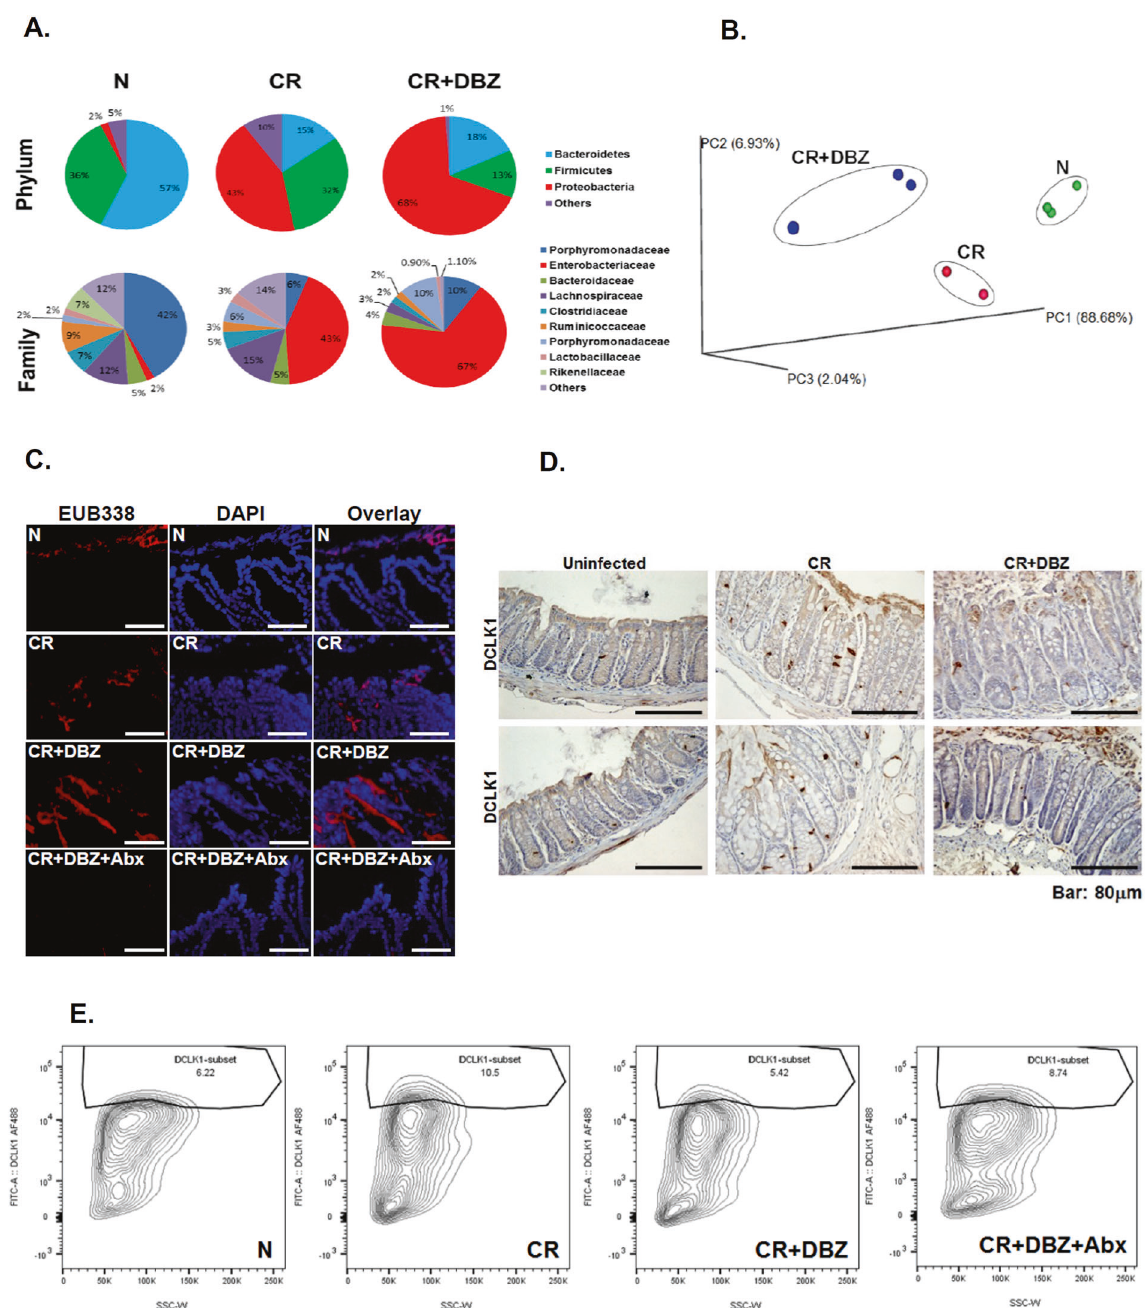
Fig. 6 Microbial dysbiosis coincides with downregulation of crypt DCLK1 following Notch blockade. A Fecal samples from uninfected (N), CR-infected (CR), and CR + DBZ-treated mice were subjected to 16S rDNA sequencing and relative abundance of phyla and families were compared. Each chart represents the taxonomic composition in the indicated groups ( n = 10 mice/group). B Principal coordinate analysis (PCoA) based on weighted UniFrac distances between bacterial communities. Please note signi fi cant separation of microbial communities in fecal samples from CR + DBZ mice when compared to either uninfected (N) or CR-infected (CR) mice ( P < 0.05). C The bacteria in the colonic tissues of N, CR, CR + DBZ, and CR + DBZ + Abx-treated mice were detected by FISH using a general bacterial 16S probe (red, TexasRed- Eub338; bar = 100 μ m; n = 3 independent experiments). DAPI was used as counterstain. D Representative images of DCLK1 staining in the distal colons of the indicated groups ( n = 10 mice/group). E Flow cytometry showing percentages of DCLK1 + cells isolated from the groups of mice indicated ( n = 10